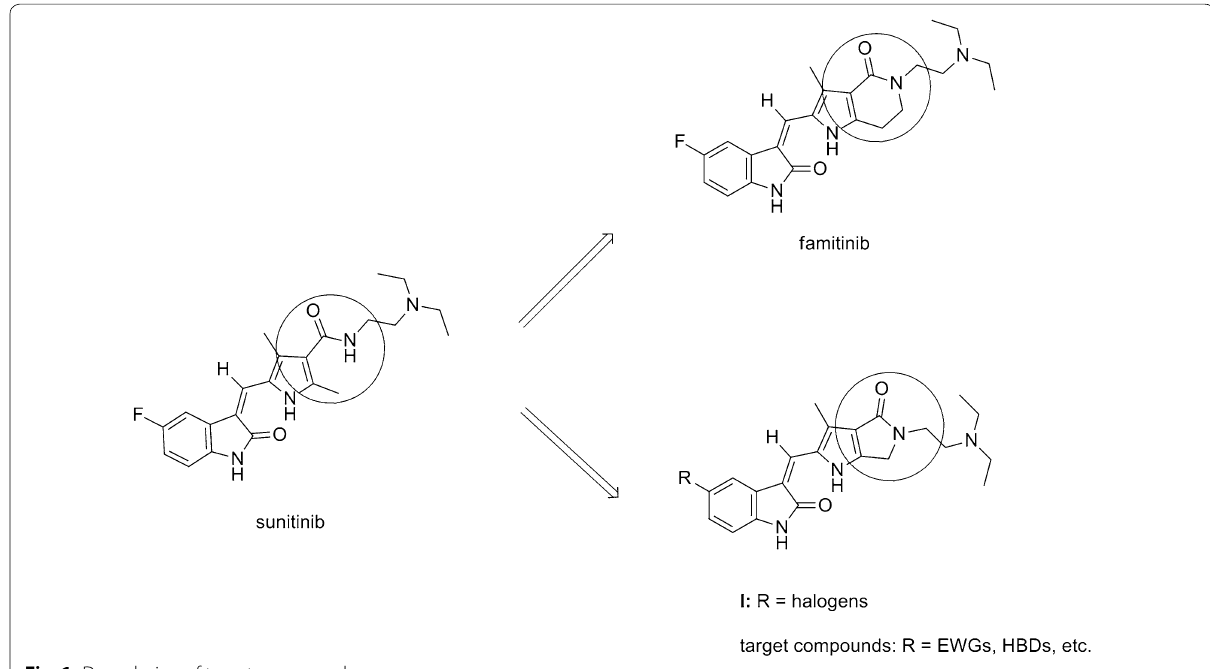
Fig. 1 Drug design of target